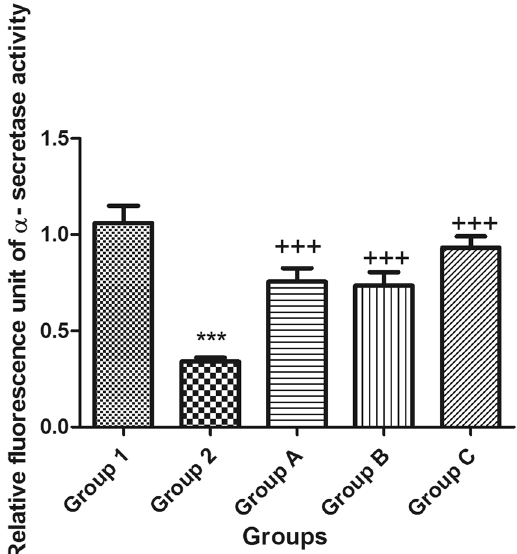
Figure 6. Effect of STZ, celecoxib, and gingerol (10 and 20 mg/kg) on the mean mouse α –secretase activity using an ELISA assay. Animals were divided into 5 groups. Group 1 received a single ICV dose of saline; then, after 2 weeks, animals were intraperitoneally injected with saline for seven days. Group 2 received a single injection of STZ (3 mg/kg, i.c.v.), and then, after 2 weeks, they were intraperitoneally injected with saline for 7 days. Group A was injected with STZ (3 mg/kg, i.c.v.) once, and after 2 weeks, they were injected with celecoxib (30 mg/kg, i.p.) for 7 days. Group B animals were injected with STZ (3 mg/kg, i.c.v.) once, and after 2 weeks, they were injected with gingerol (10 mg/kg/day, i.p.) for 7 days. Group C was injected with STZ (3 mg/kg, i.c.v.) once, and after 2 weeks, they were injected with gingerol (20 mg/kg/day, i.p.) for 7 days. Animals from groups A, B, and C were subjected to tests after the 3 rd week of injections. Each result represents the mean value for 10 mice ± SE of the mean. Statistical analysis was carried out by one-way ANOVA followed by Tukey-Kramer multiple comparison test by the aid of Graph Pad Prism Software version 5. *** Significantly different from normal group P < 0.001. +++ Significantly different from STZ group P <